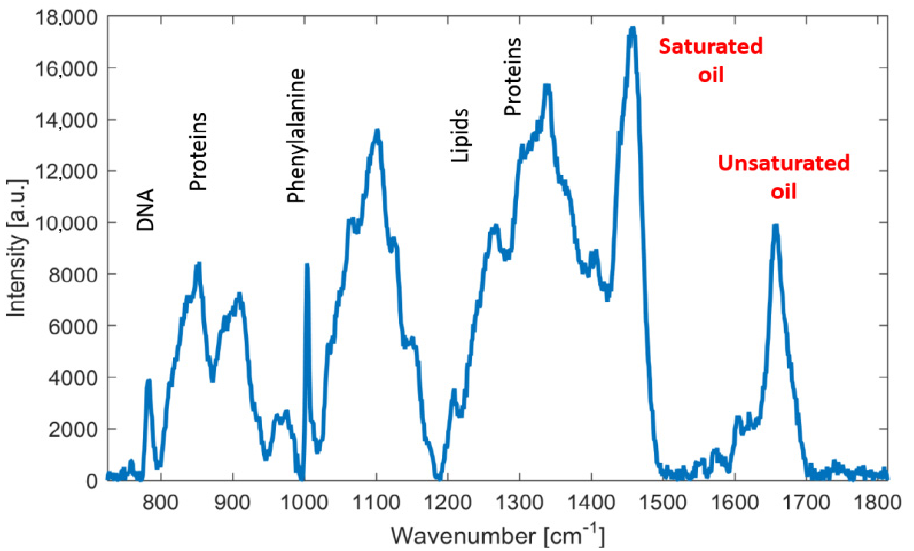
Figure 6. Raman spectra of oil fraction extracted from Metschnikowia pulcherrima 29-2-149. Selected emission lines are highlighted - the two lines used for the iodine number estimation are marked in red.